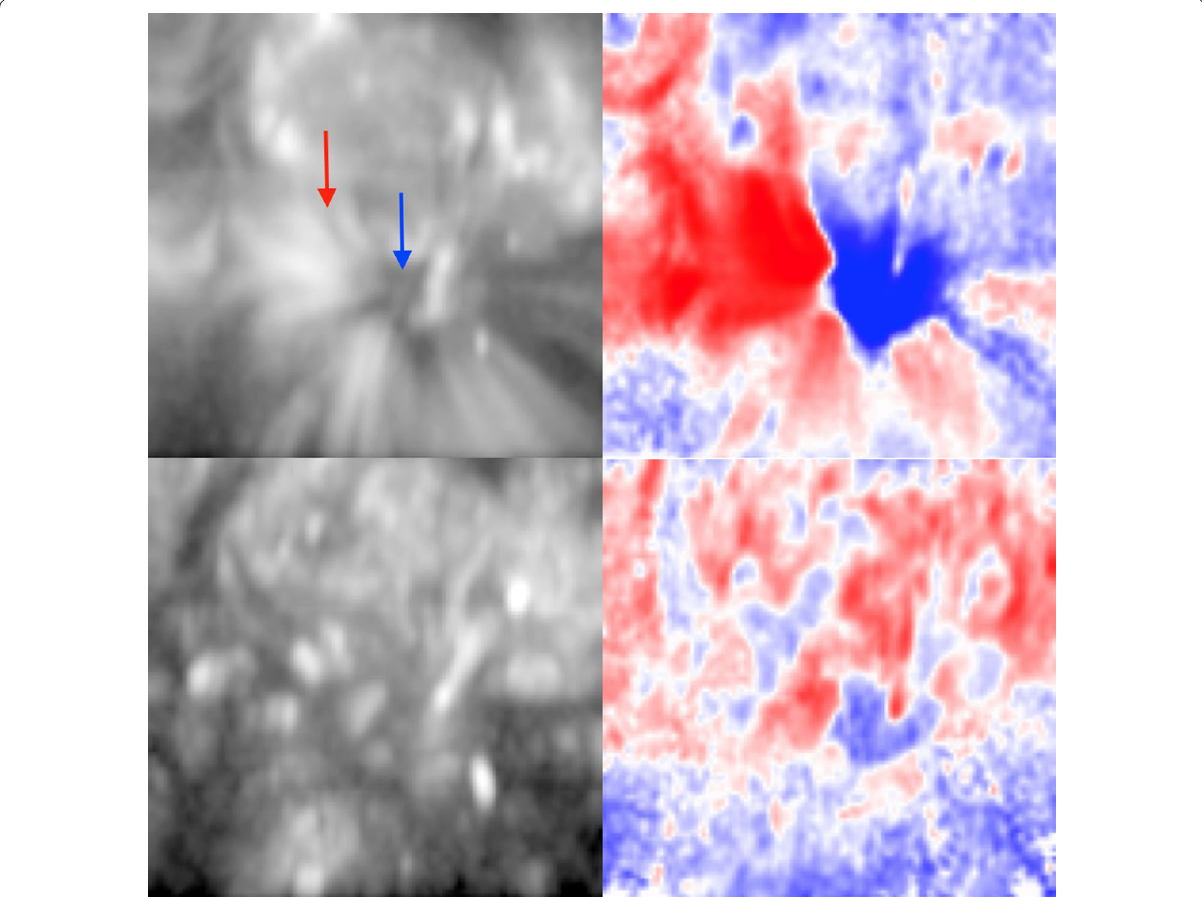
Fig. 2 Intensity images (left) and Dopplergrams (right) of two TR lines taken by SUMER on August 2, 1996. The upper and lower panels show the results for the Ne VIII 770 Å and C IV 1548 Å lines, respectively. The red and blue arrows indicate a sunspot plume and the umbra, respectively. The field of view of each image has a size of about 120 ″ 120 ″ . These images are taken from SUMER Image Database: http://www2.mps.mpg.de/ × projects/soho/sumer/text/s024503.html. The same dataset has also been analyzed by Marsch et al.